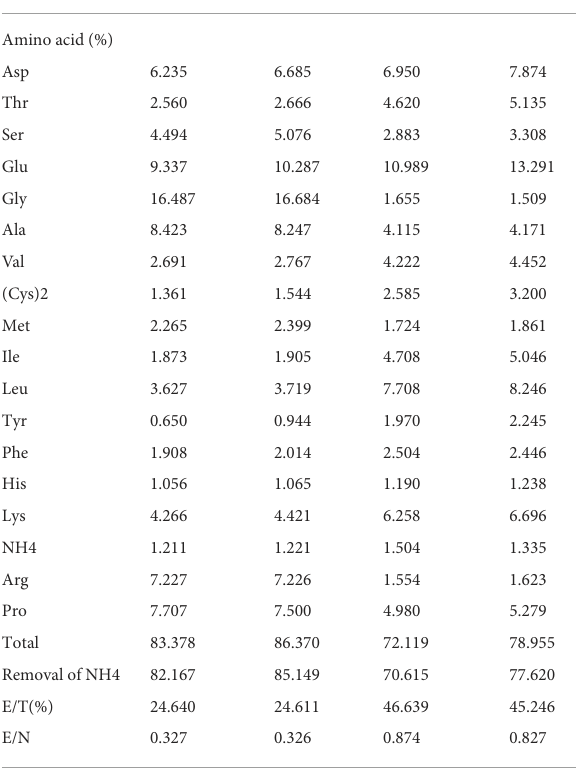
TABLE 3 Weight of pregnant rats under iron deficiency and iron supplementation intervention